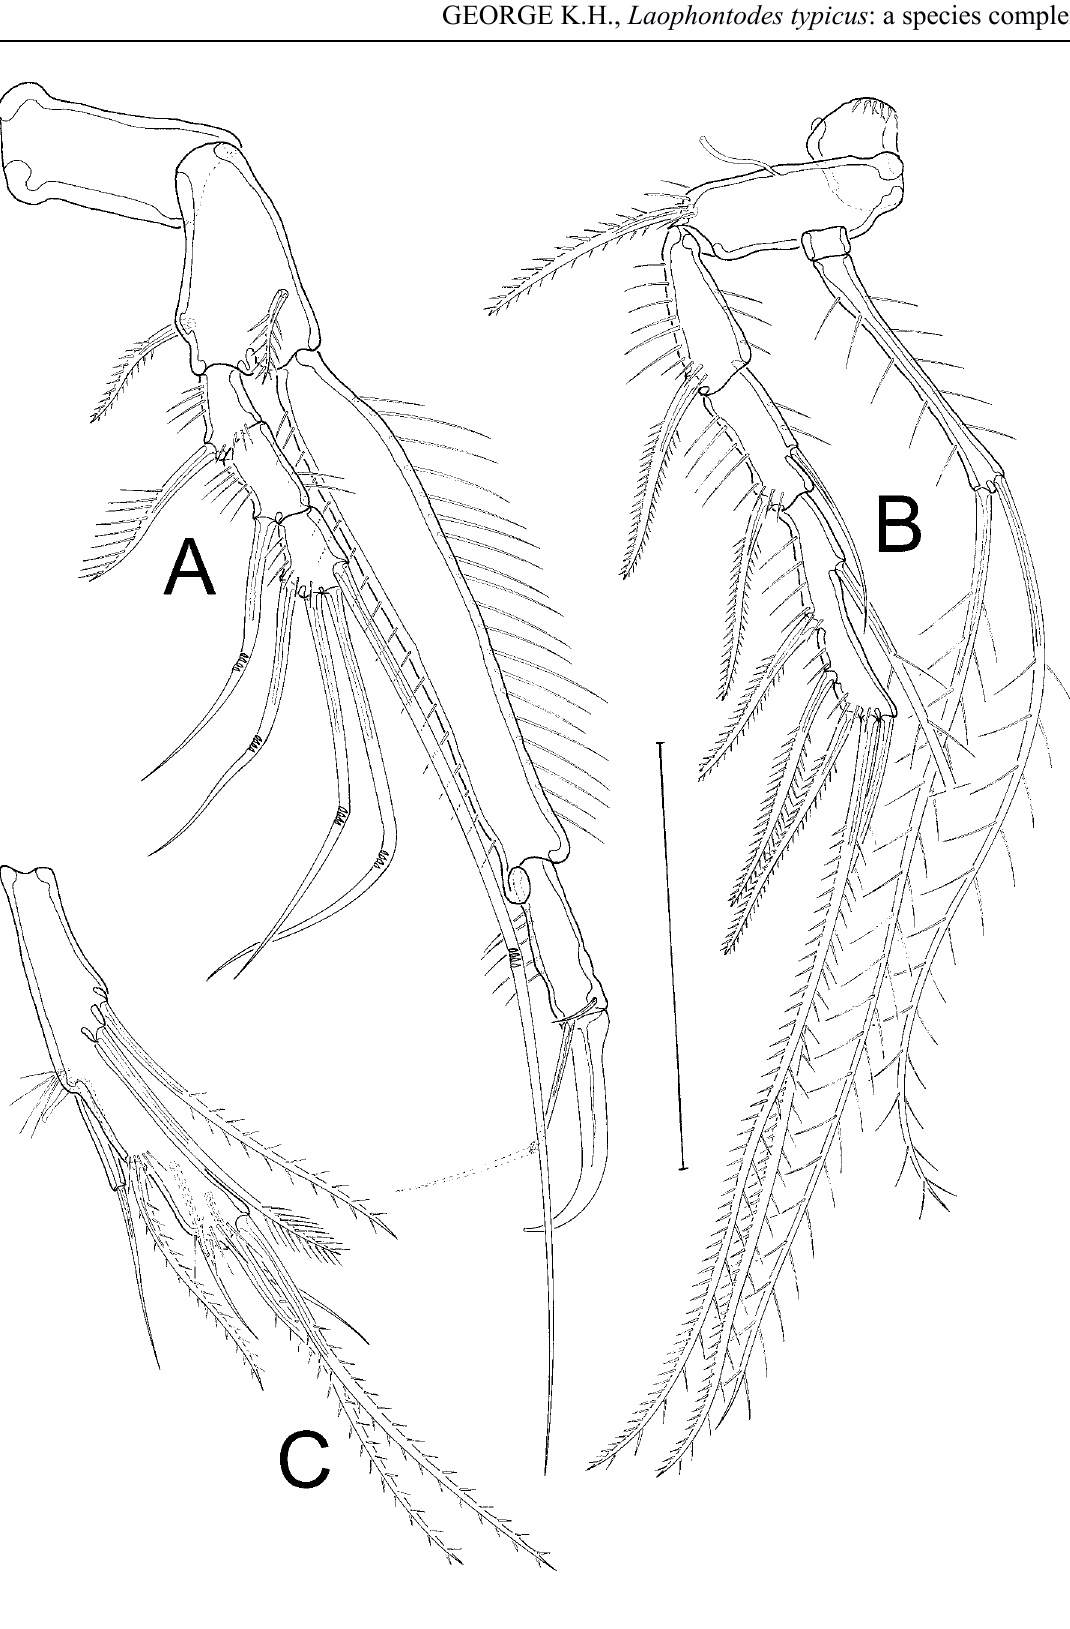
Fig. 18. Laophontodes monsmaris sp. nov., allotype, ♀ (SMF 37121/1). A . P1. B . P2. C . P5. Scale = 50